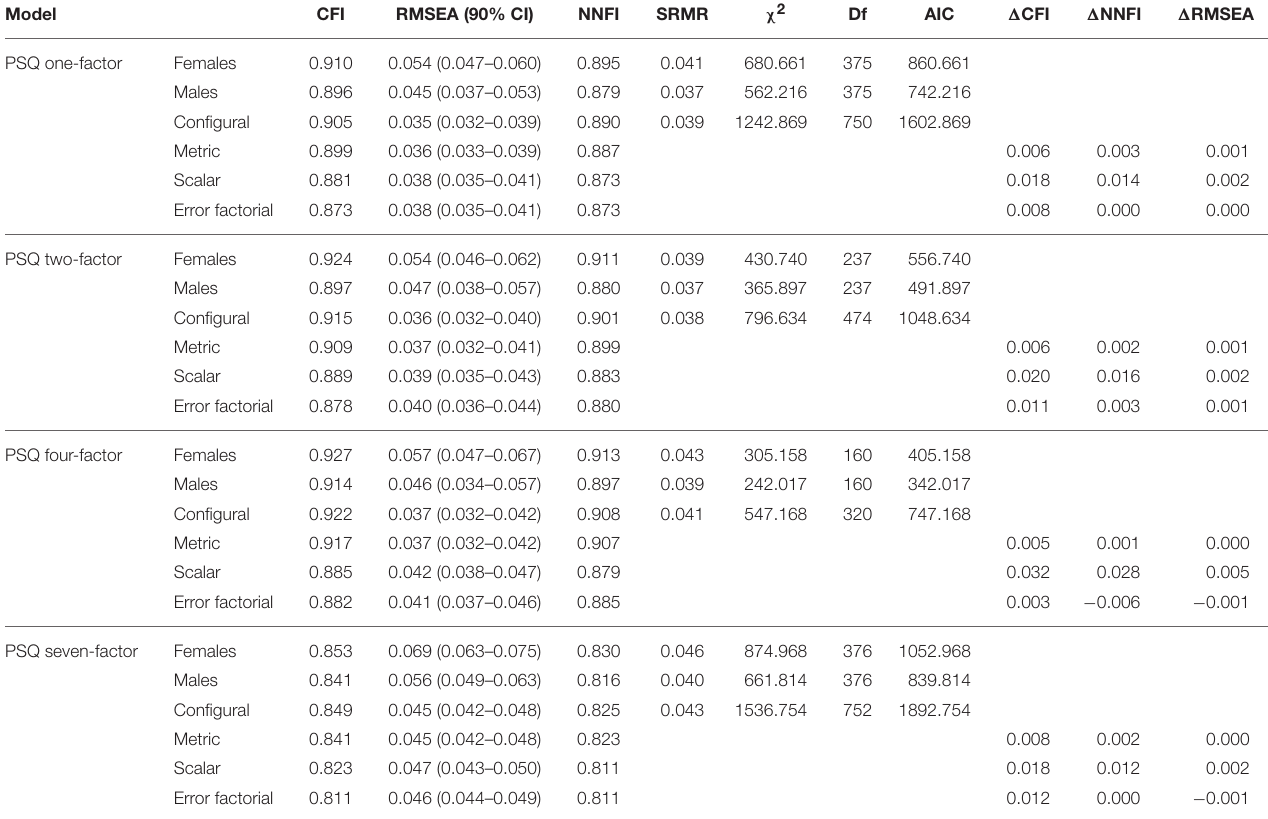
TABLE 2 | Model fit and measurement invariance tests across gender for the Norwegian version of the PSQ, according to the one-factor, two-factor, four-factor, and seven-factor model, N = 524. Model